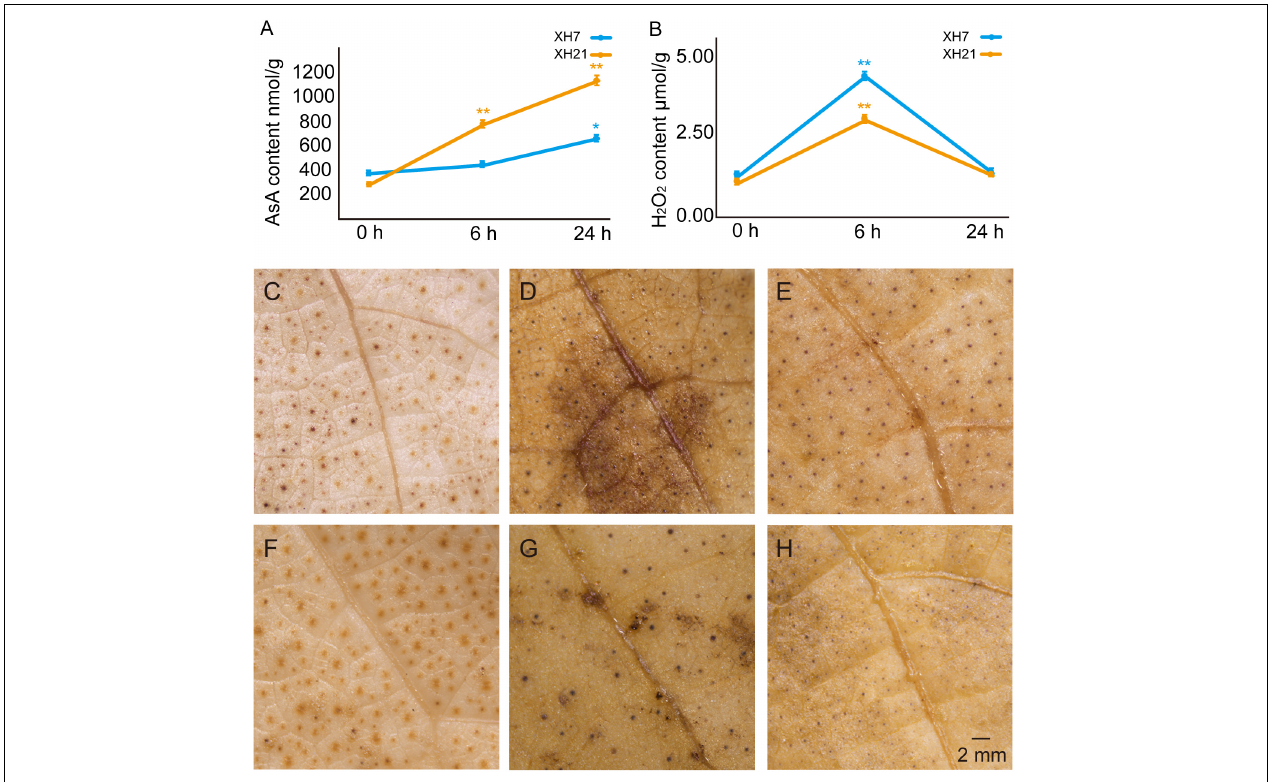
FIGURE 3 | Detection of the AsA and H 2 O 2 contents in XH7 and XH21 after V. dahliae incubation. AsA (A) and H 2 O 2 (B) contents were determined in XH7 and XH21 roots treated with V. dahliae for 0, 6, and 24 h, respectively. * p < 0.05; ** p < 0.01. DAB staining of leaves of XH7 (C–E) and XH21 (F–H) after V. dahliae treatment for 0 h (C,F) , 6 h (D,G) , and 24 h (E,H) are shown. The stained H 2 O 2 is indicated with a brown color. Bar = 2 mm.